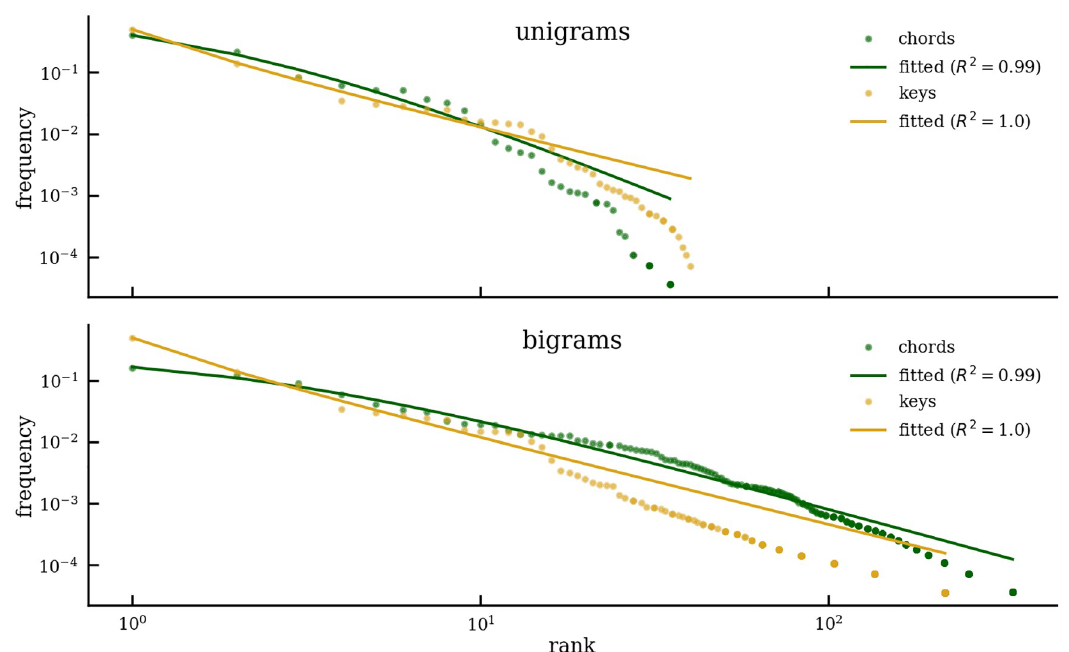
Fig 11. Chords vs. keys. Best fit of Zipf-Mandelbrot function to unigram (top) and bigram (bottom) rank vs. frequency curves as indicated by the coefficient of determination R 2 .